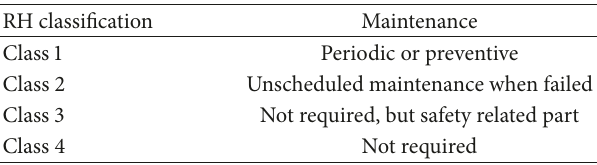
Table 1: Remote handling (RH) classification for process equipment